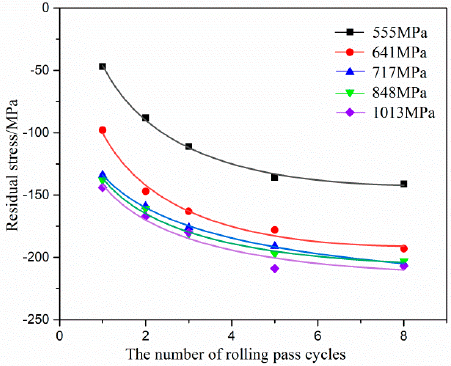
Figure 5. Influence of rolling pass cycle on residual stress.